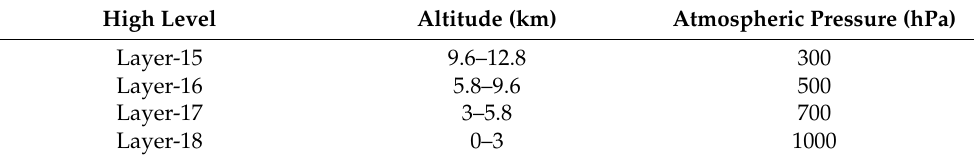
Table 2. Altitude layer of OMI ozone profile and the corresponding atmospheric pressure.